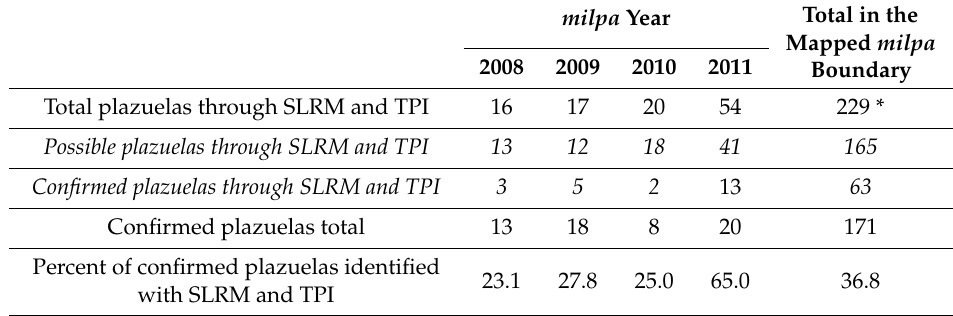
Table5. Surveyed, SLRM,andTPIplazuelasidentifiedwithin milpas from2008to2011(seeReference[9]). (* Note: One SLRM and TPI plazuela identified within the milpa boundary is a false